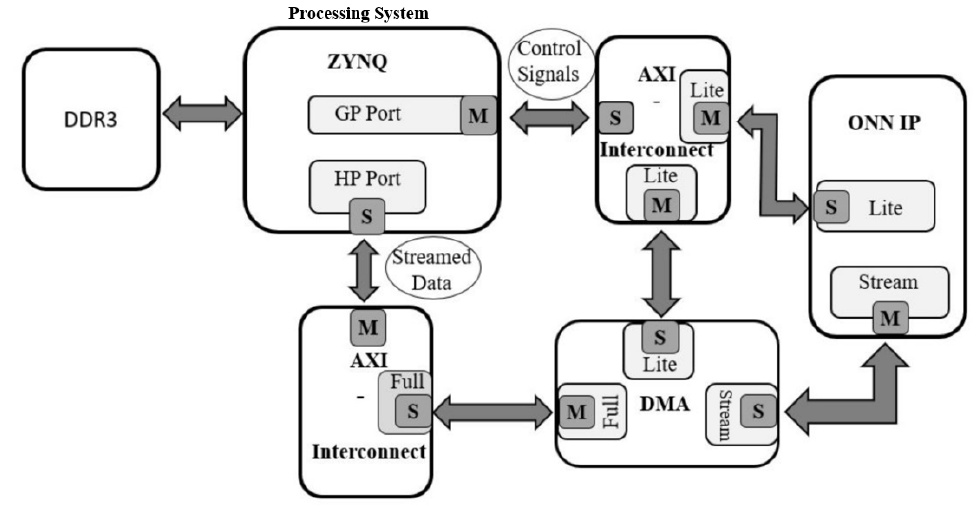
Figure 6. The proposed system design using